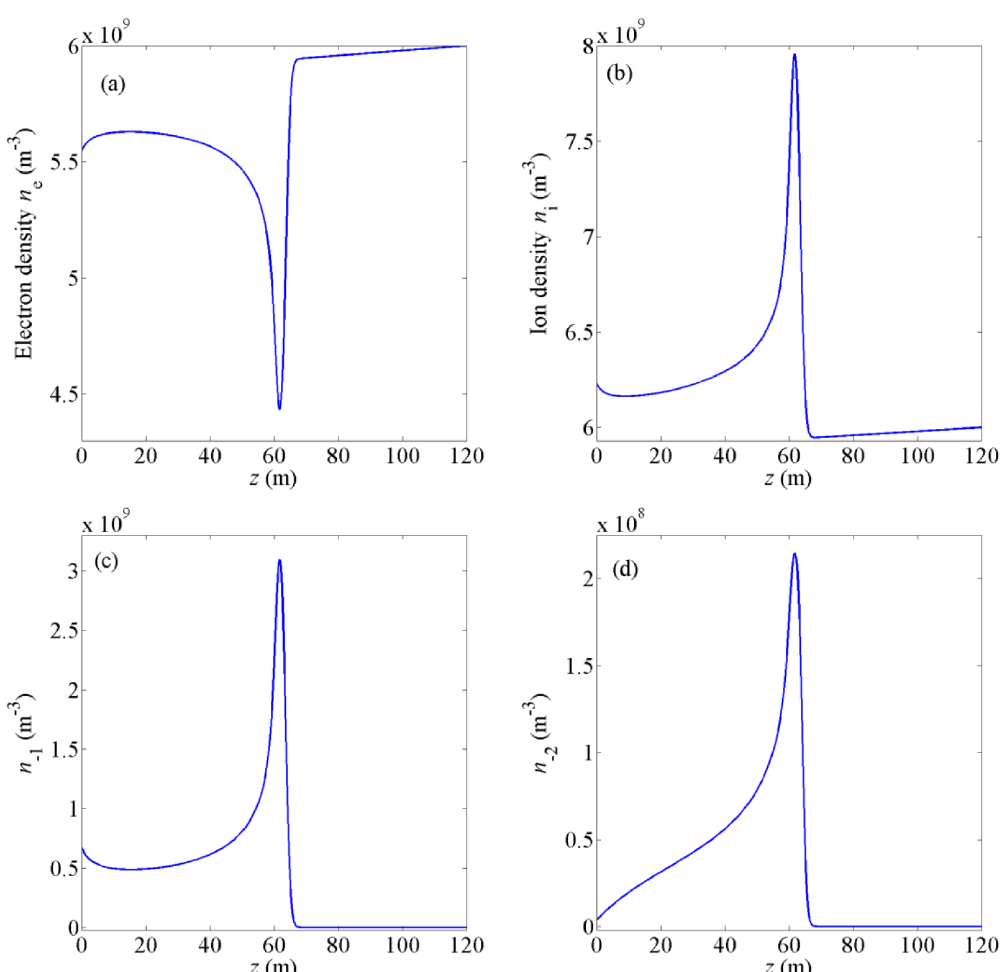
Figure 3. Number density distribution of (a) electrons n e , (b) ions n i , (c) particles carrying one negative charge n − 1 , and (d) particles carrying two negative charges n − 2 near the lower boundary of the condensation layer at t =